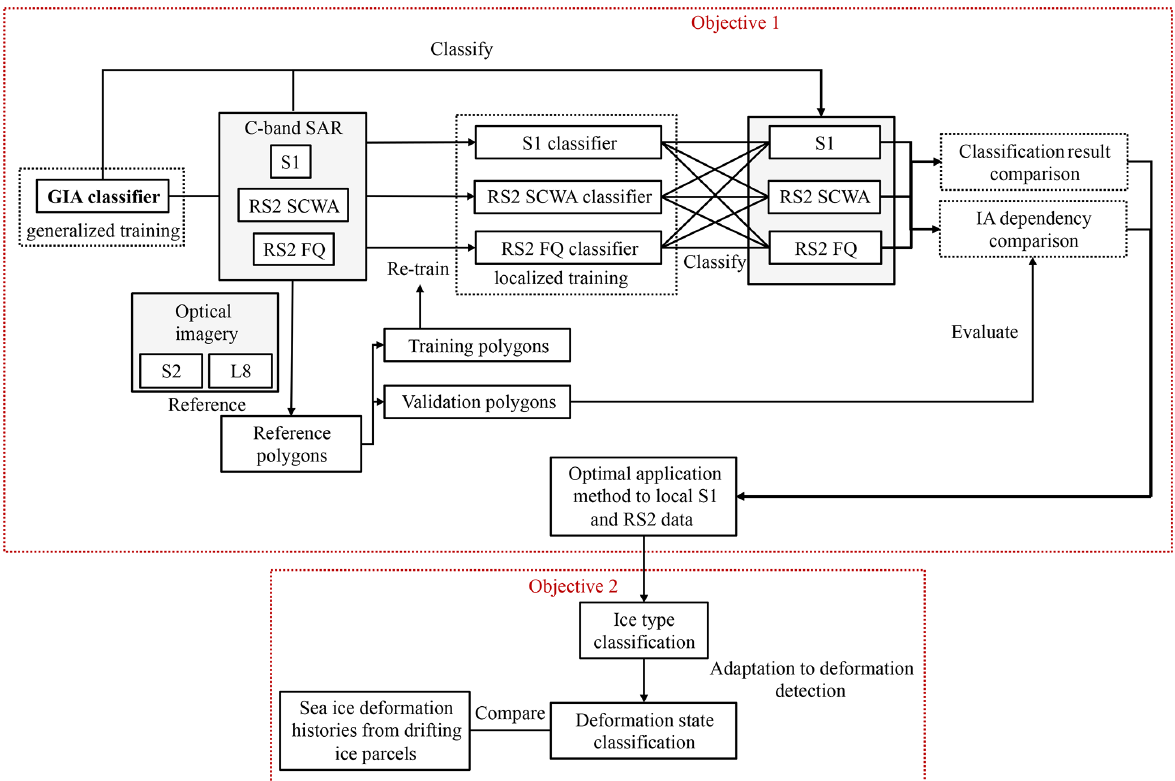
Figure 1. Flowchart of materials and methods used in this